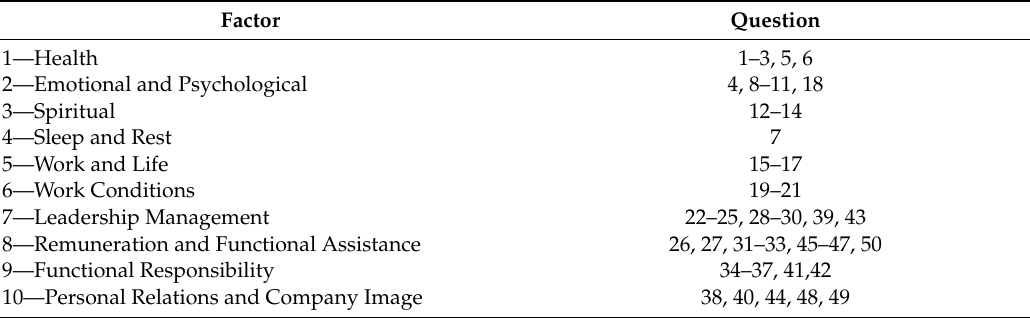
Table 4. Factor names according to the question